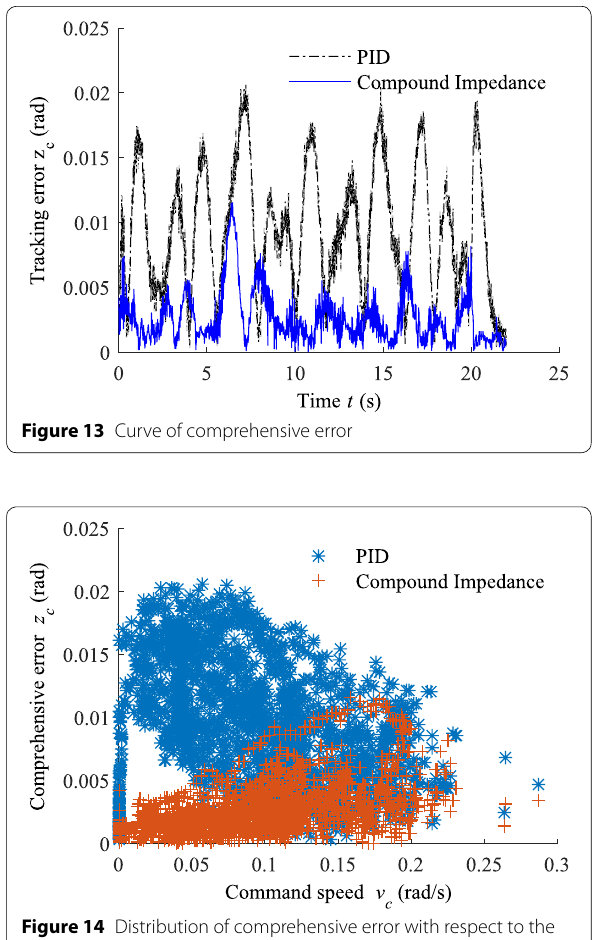
Figure 14 Distribution of comprehensive error with respect to the command